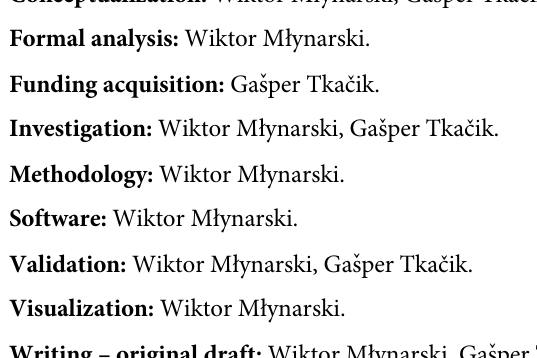
bottom row: uncertainty vs. representation accuracy. Each scatter density plot displays 10,000 points. Red, dashed lines depict the linear fit. ( B ) Same as (A) but for the orientation estima- tion task. S2 Fig. Impact of the attentional constraint ψ on uncertainty-activity and uncertainty- accuracy relations in the orientation-estimation task. ( A ) Uncertainty decile vs. normalized population activity (analogous to Fig 7B) for two values of the attentional constraint ψ . ( B ) Correlation between uncertainty and population activity as a function of the attentional con- straint ψ . ( C ) Uncertainty decile vs. encoding accuracy (analogous to Fig 7D) for two values of the attentional constraint ψ . ( D ) Correlation between uncertainty and representation accuracy as a function of the attentional constraint ψ . S3 Fig. Average time courses of uncertainty and threshold (gain) variance. ( A ) Object detection task. Top: time course of posterior uncertainty (in bits) averaged over 500 switches between the environmental states (marked with a green-orange bar at the top). Bottom: time course of variances of neural thresholds xi averaged over 500 switches between the environ- n , t mental states and neurons in the population. ( B ) Same as (A) but for the orientation estima- tion task. S4 Fig. Additional analyses of the gain autocorrelations and cross-correlations for simula- tions of spatial tracking task in Fig 6B. ( A ) Log-probability histogram of the peaks of gain cross-correlation functions across all pairs of neurons. ( B ) Distribution of extreme (maximal and minimal) values of cross-correlation functions. ( C ) Distribution of decay times of autocor- relation functions of gains of individual neurons. Decay time was determined as the number of time samples after each the autocorrelation dropped below 0.1. ( D ) Distribution of largest autocorrelation values (after excluding the peak at τ = 0). ( E ) Example cross-correlation func- tions of individual pairs of